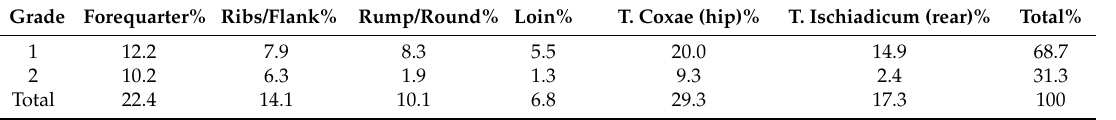
Table 4. Gradation of bruises and the prevalence of the location on the